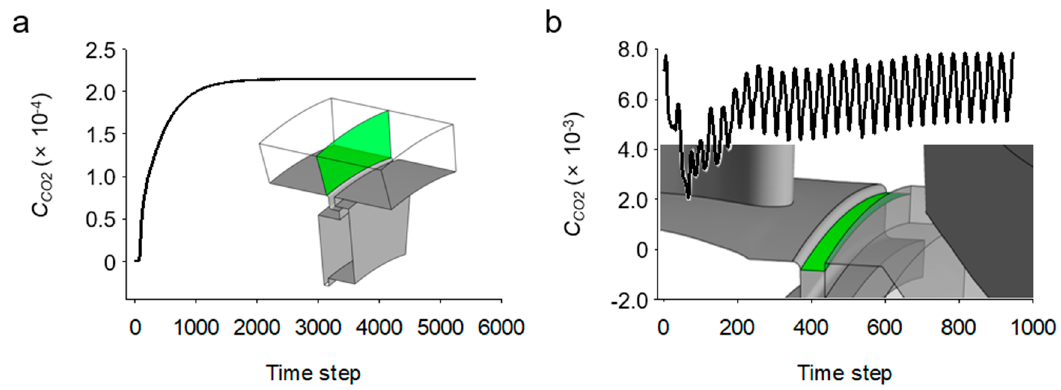
Figure 1. Monitoring of the area average mass fraction of CO 2 in green coloured plane to confirm flow stability for (a) Type 1 C and (b) Type 2 C.